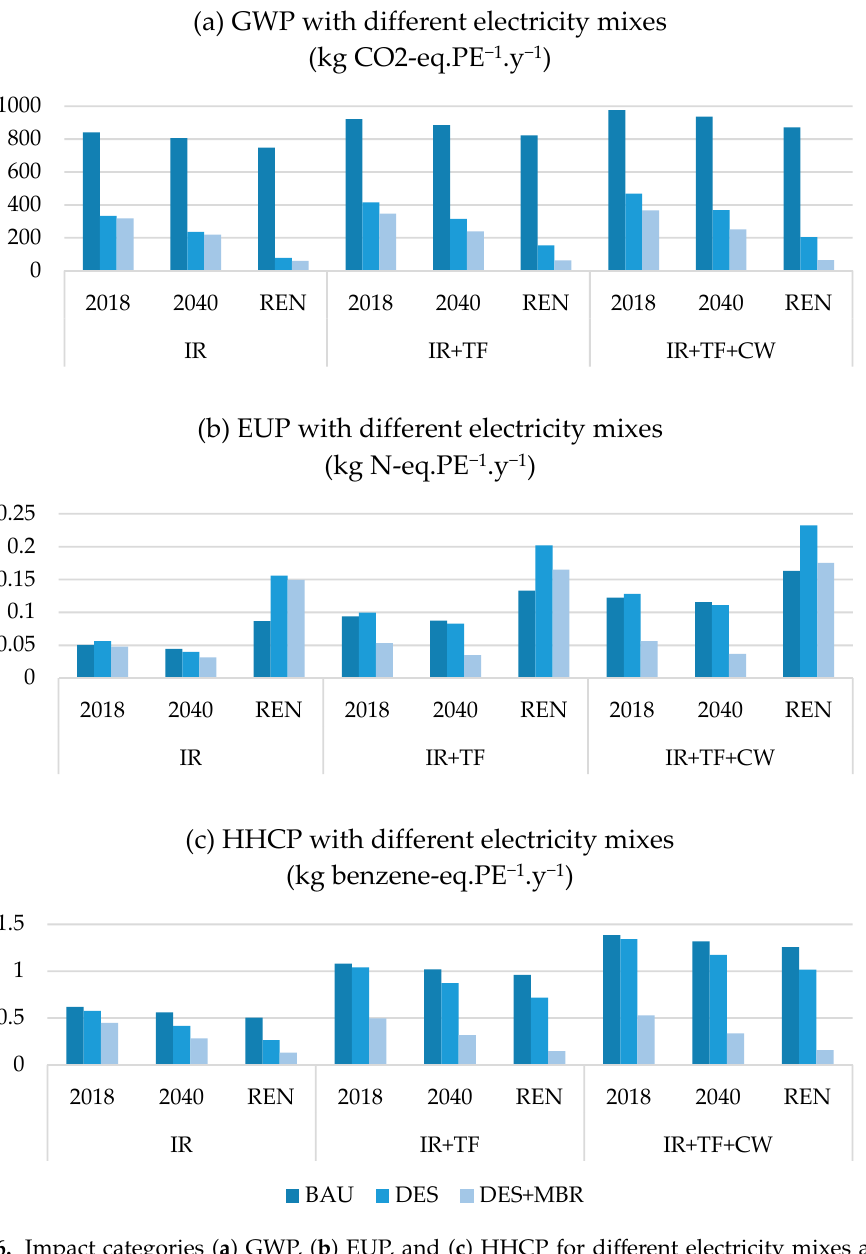
Figure 6. Impact categories ( a ) GWP, ( b ) EUP, and ( c ) HHCP for different electricity mixes across the three systems modelled: 2018, 2040, and renewable (REN); irrigation (IR), toilet flushing (TF), and clothes washing (CW).